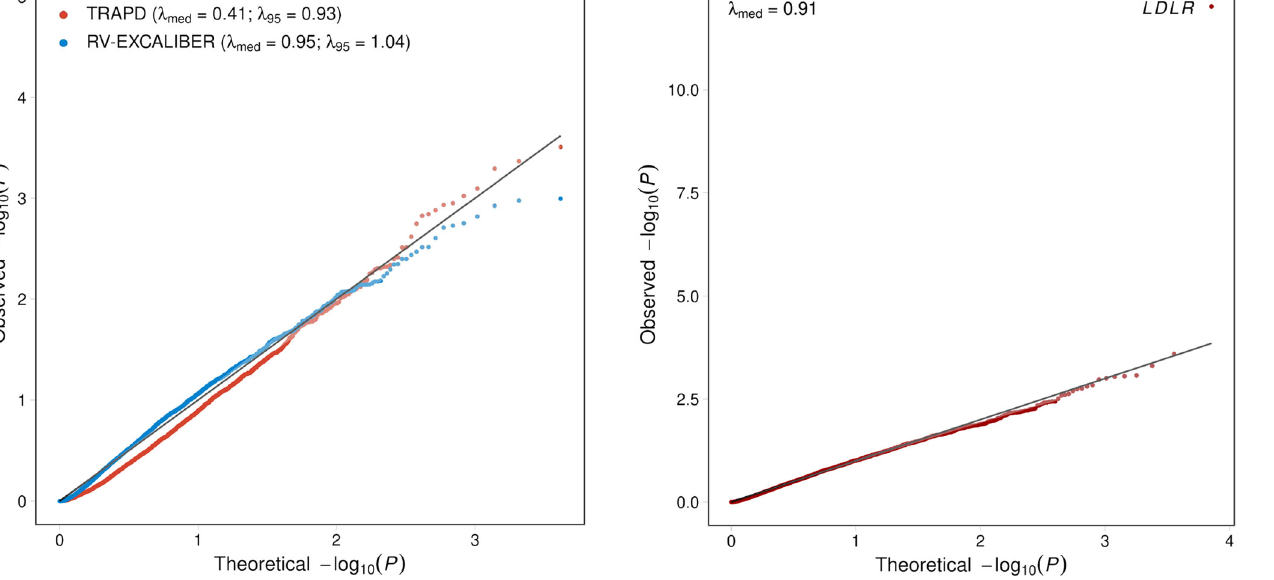
Fig. 6 Quantile-quantile plot for discovery gene-based test statistics generated using RV-EXCALIBER for 5910 case participants from MIGen. A total of 7146 protein-coding genes with OAC ≥ 1 in MIGen and EAC ≥ 10 in gnomAD non-Finnish Europeans were used to conduct a gene burden testing with the RV-EXCALIBER method. Association testing was conducted using 5,910 MI cases in MIGen and gnomAD non-Finnish Europeans as controls. The genomic in fl ation estimate at the median ( λ med was determined to be 0.91. The solid black line indicates an expected uniform distribution of P -values under the null and the shaded region represents the 95% con fi dence interval of the expected uniform distribution of P -values. log 10 ( P ) refers to the log base 10 of a gene-based P - value. Source data are provided as a Source data fi